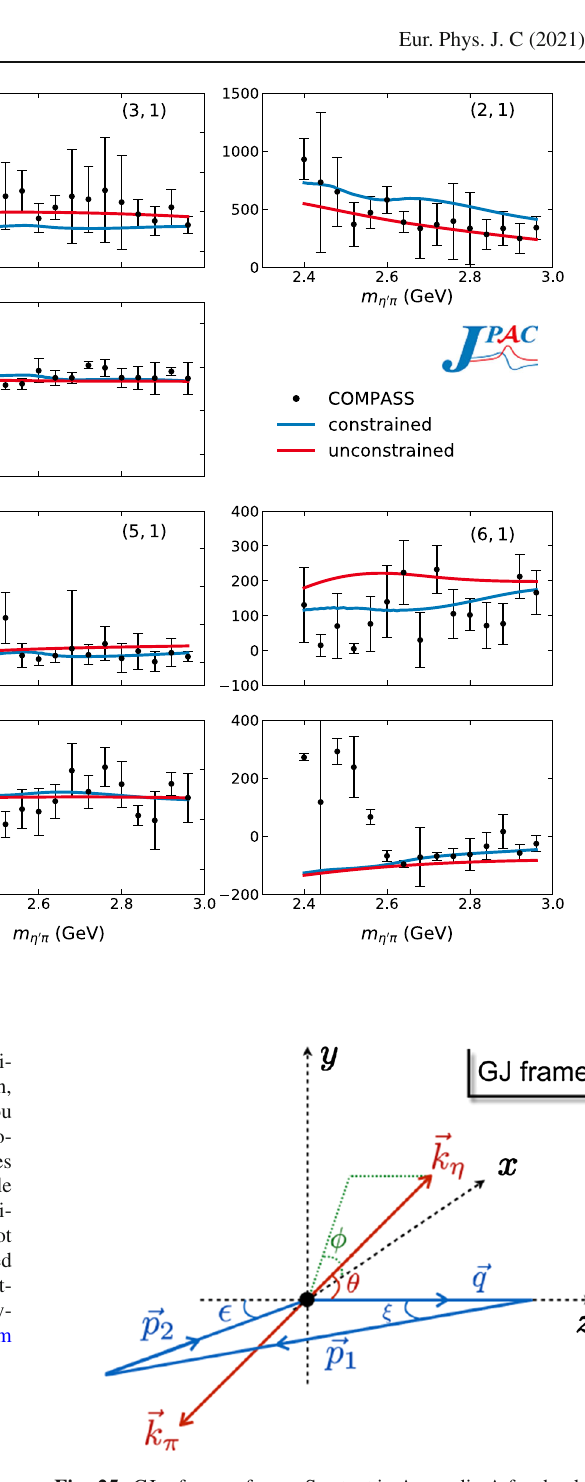
In the ηπ center-of-mass, the ˆ z -axis is along the beam and the ˆ y -axis, perpendicular to the production plane, is parallel to q × p 2